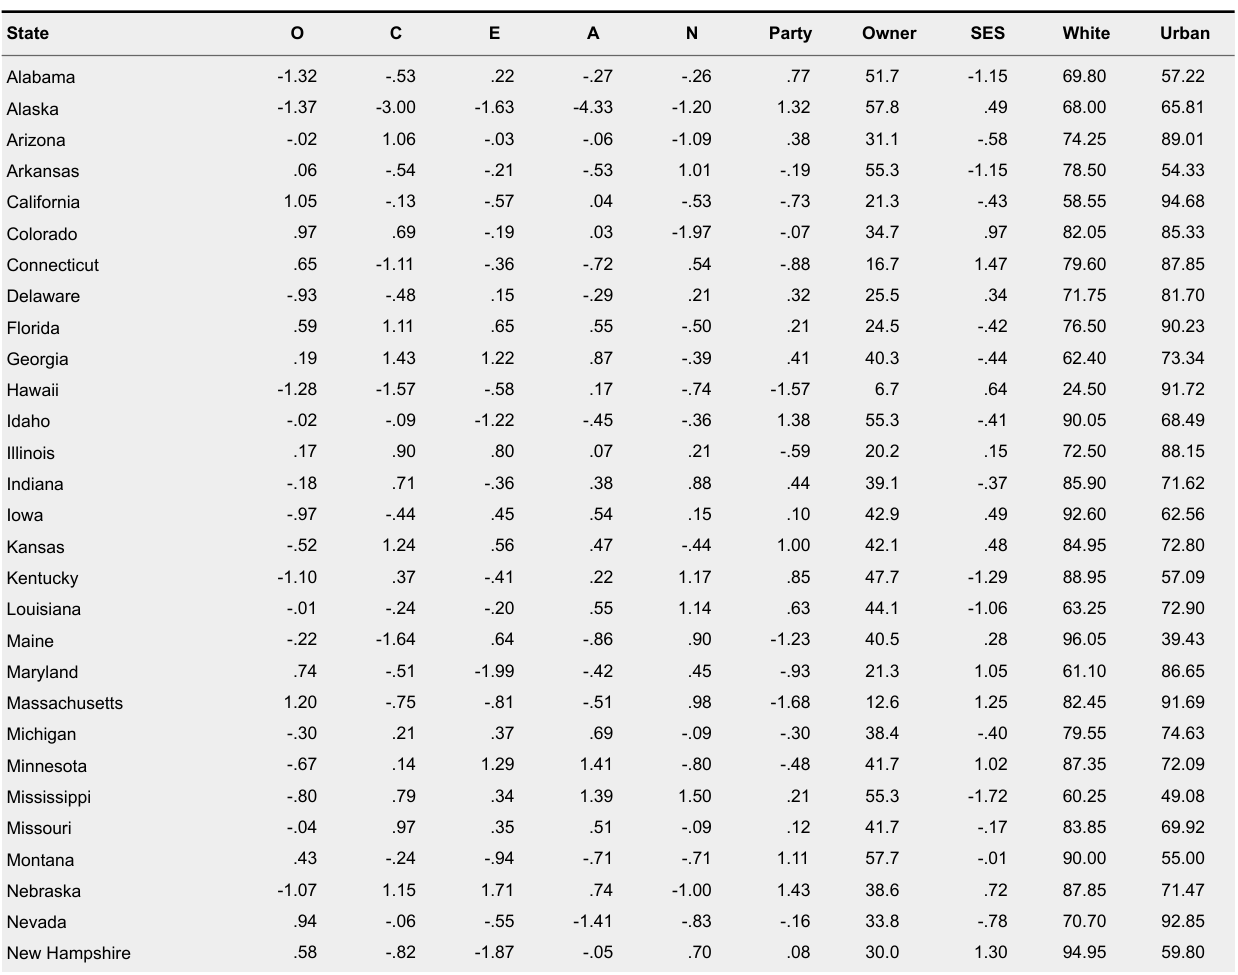
State Scores for the 11 Variables in the Main Analyses of the Present